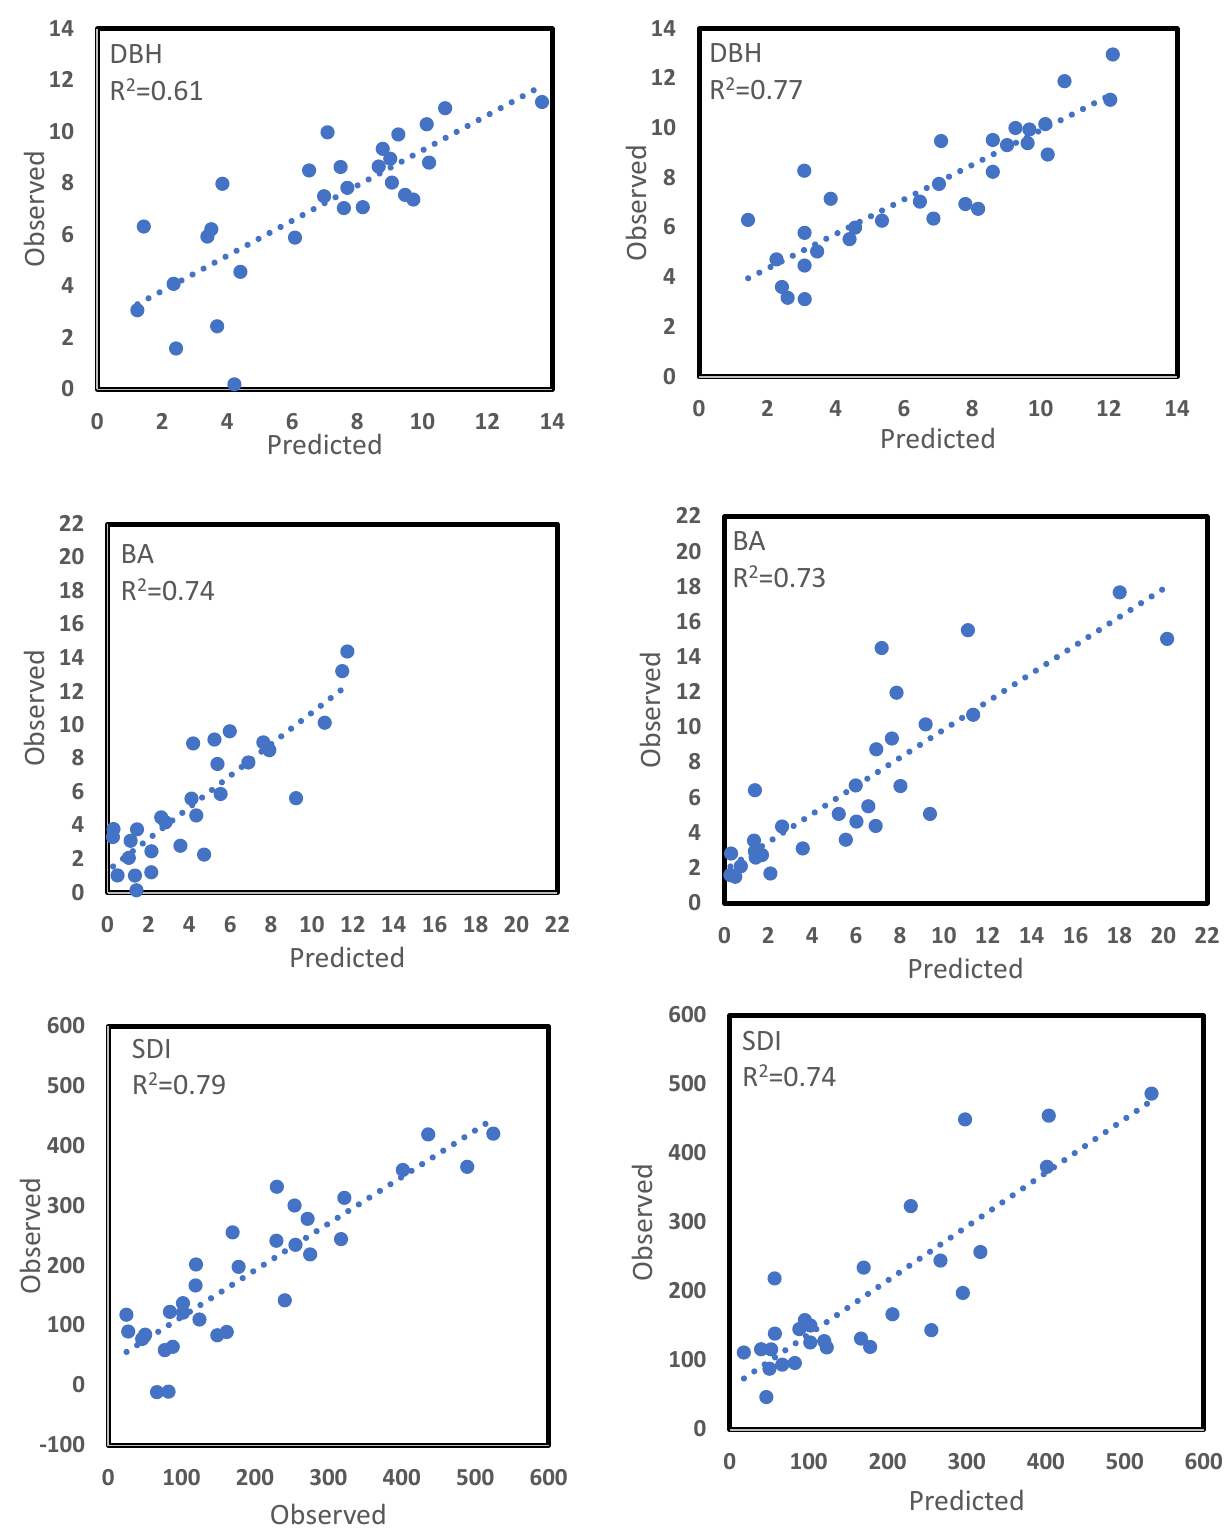
Figure 2. Relationships between observed and predicted values based on the independent test dataset of the 1st cycle measurement: multiple linear regression models on left column and random forests models on the right column.